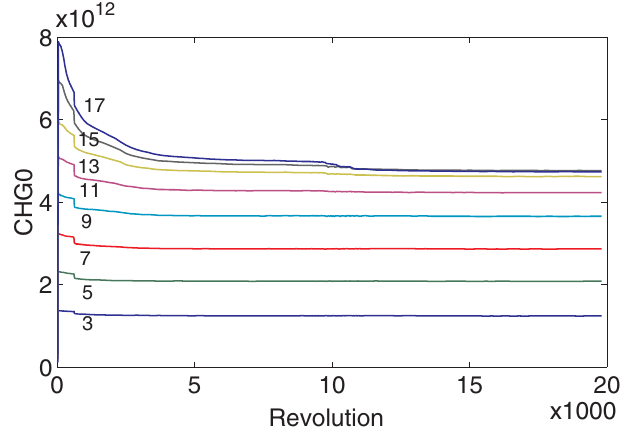
FIG. 1. (Color) Total charge (CHG0, in 10 12 ) for data sets with 3, 5, 7, etc., injection turns. Note that the notch of beam loss at about revolution-600 is created intentionally by kicking 3 bunches out to facilitate a gap for the extraction kicker. Transition-energy loss is visible at the transition energy at about 9550